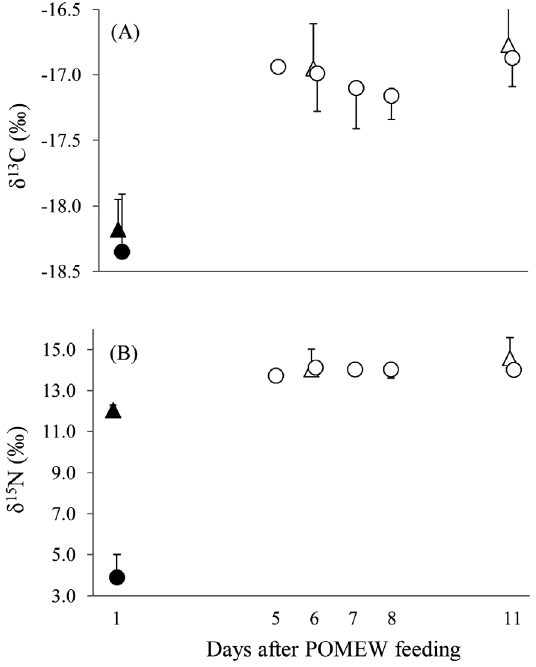
Fig. 5. Trajectories of d 13 C (A) and d 15 N (B) in leptocephali fed DSE (open triangle) and POMEW (open circle) in 2013. Stable isotope ratios of DSE and POMEW are shown by closed triangle and closed circle, d 15 N values between leptocephali fed POMEW350 and DSE (14.0 ± 0.3 ‰ and 14.2 ± 0.5 ‰ , respectively) (Mann – Whitney U test, P > 0.07).